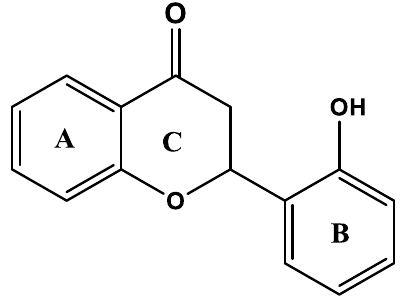
Figure 1. Chemical structure of 2-hydroxyflavanone.